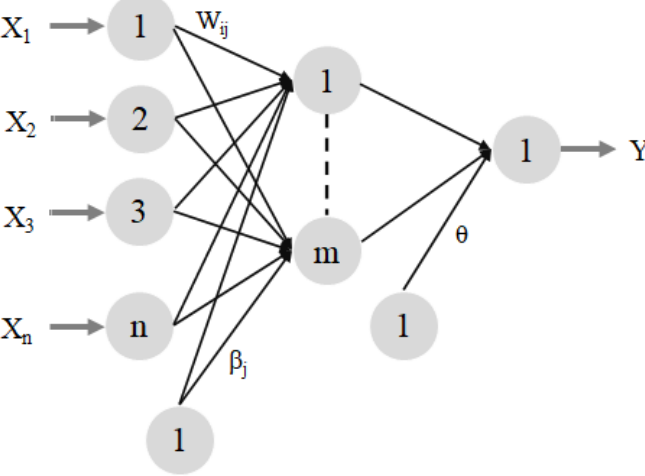
Figure 2. Basic structure of a Multi-layer Perceptron (MLP).